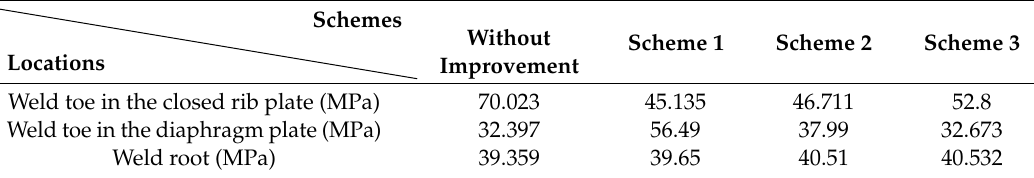
Figure 16. Stress–node position curves in the rounded welding region before and after improvement: Stress curves of ( a ) weld toe in the closed rib plate, ( b ) weld toe in the diaphragm plate and ( c ) weld root. Table 4. Peak value of the maximum principal stress in the rounded welding region before and after improvement.